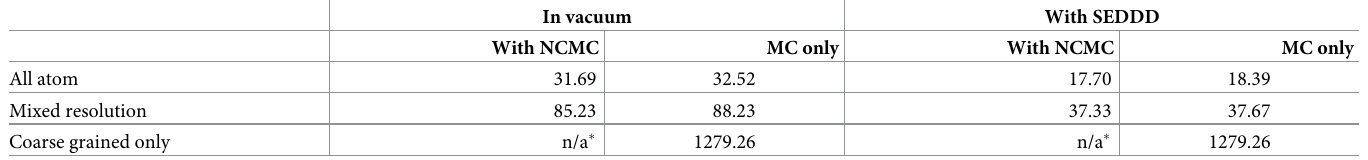
Table 3. Comparison of computation speeds (MC trial moves per second) for different resolution representations of ER α in complex with